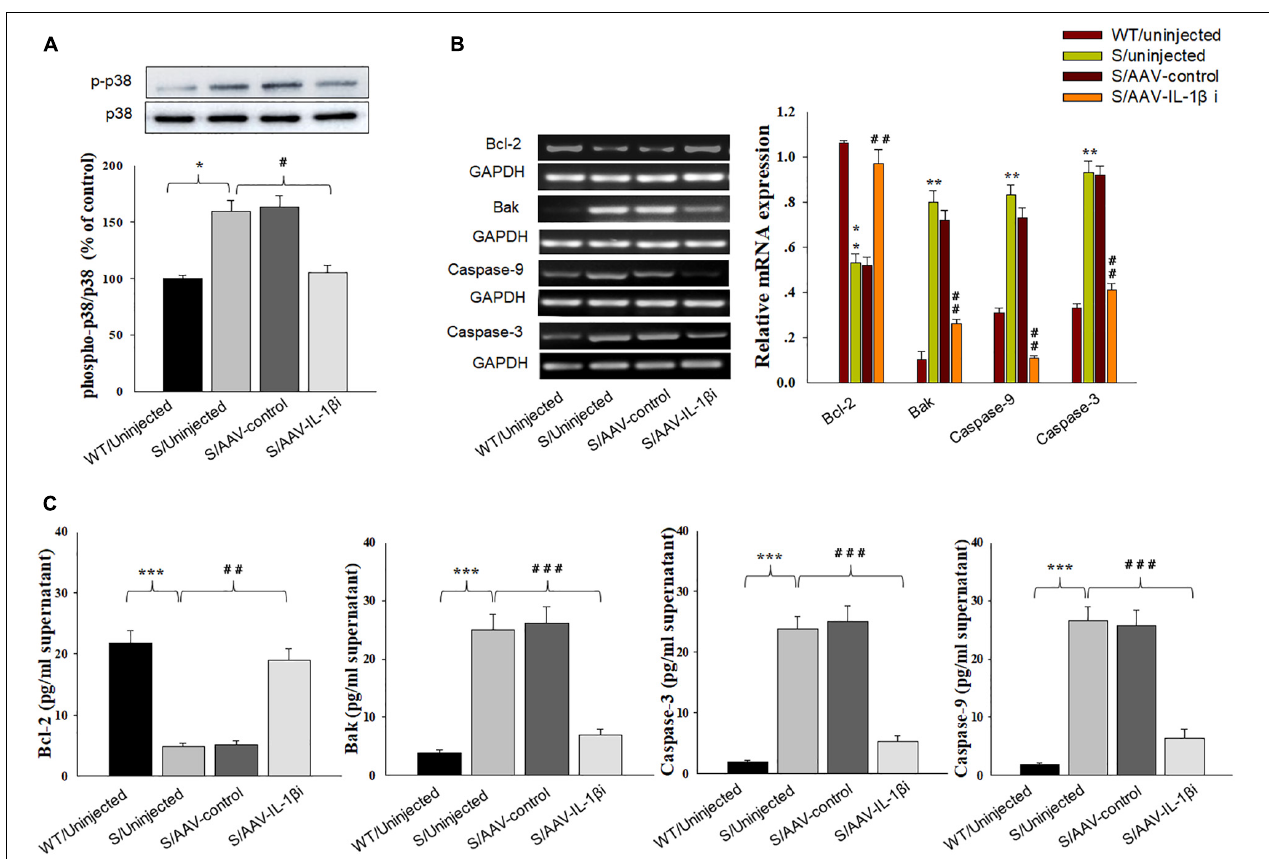
FIGURE 9 | Knocking-down of IL-1 β in vmPFC reduced apoptosis-related factors produced by CUMS exposure. (A) Phosphorylation levels of p38 MAPK in the vmPFC infected with the AAV-IL-1 β RNAi virus. (B) RT-PCR assays of expression levels of Bcl-2, Bak, Caspase 3 and Caspase 9 in vmPFC neurons infected with the AAV-IL-1 β RNAi construct. (C) ELISA assays of expression levels of Bcl-2, Bak, Caspase 3 and Caspase 9 in vmPFC neurons infected with the AAV-IL-1 β RNAi construct. N = 6/group. ∗ P < 0.05, ∗∗ P < 0.01, ∗∗∗ P < 0.001 Stressed rats vs. WT rats. # P < 0.05, ## P < 0.01, ### P < 0.001 S+AAV-IL-1 β RNAi vs. Stressed